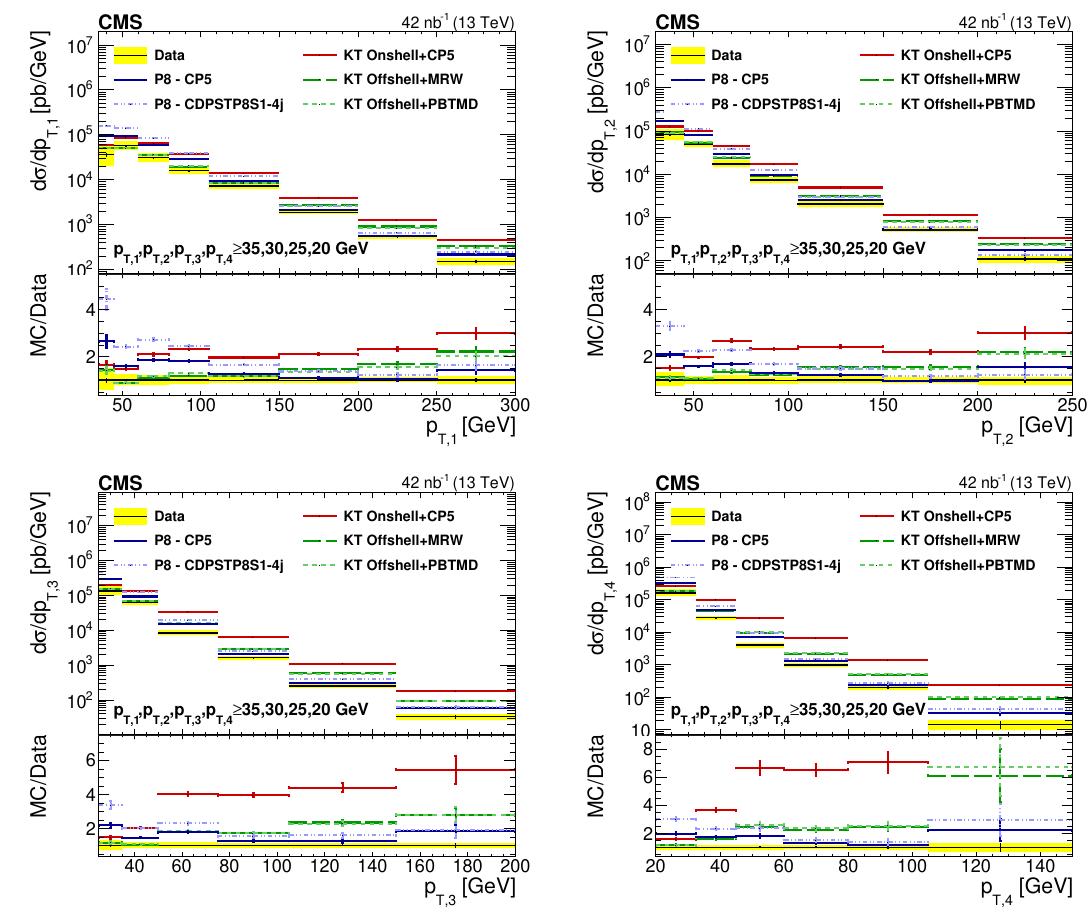
spectra of data with different SPS+DPS KaTie (KT) Figure 10 . Comparison of the unfolded p T and pythia 8 (P8) models, for the leading (upper left), subleading (upper right), third leading (lower left), and fourth leading (lower right) jet in Region I. The error bars represent the statistical uncertainty, and the yellow band indicates the total (statistical+systematic) uncertainty in the